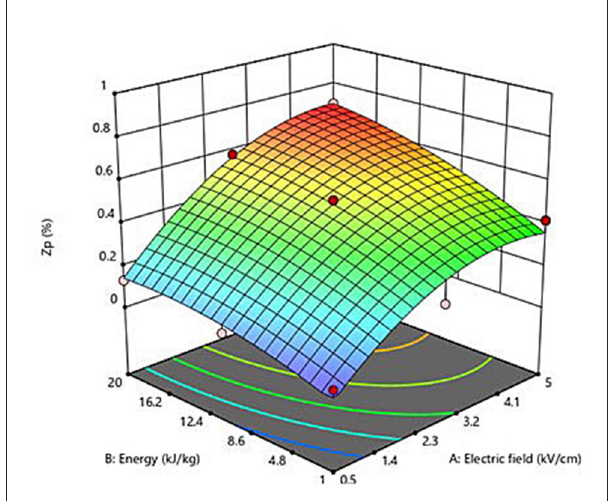
FIGURE1 Response surface plot showing the influence of electric field strength (kV/cm) and energy input (kJ/kg) on the cell disintegration index ( Z p ) of grape pomace